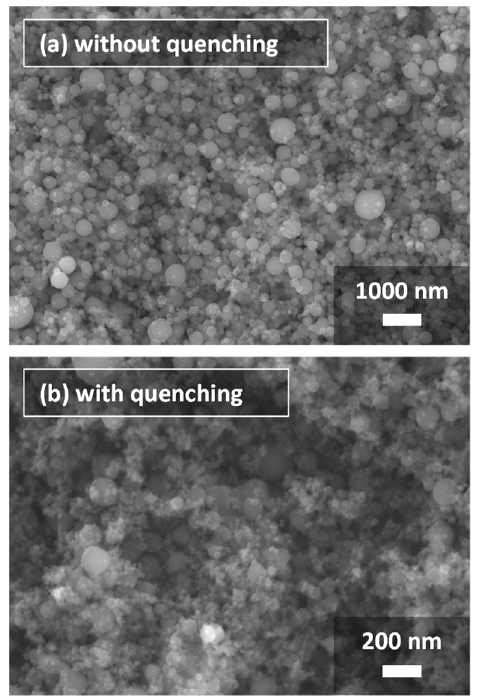
Figure 4. SEM images of silicon nanoparticles obtained through experiments ( a ) without and ( b ) with quenching.